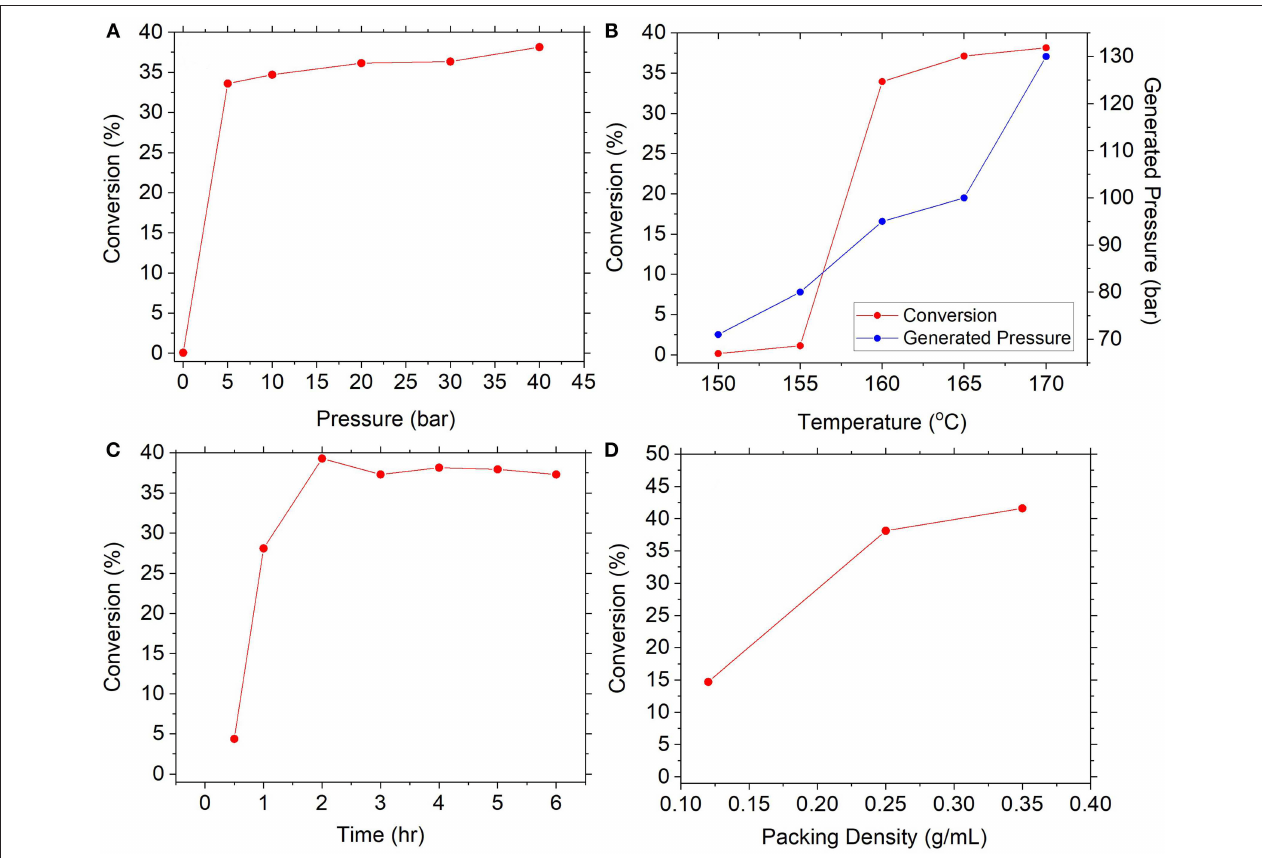
FIGURE 6 | Effect of various reaction conditions on conversion of ammonium carbamate, namely (A) pressure, (B) temperature, (C) reaction time, and (D) carbamate packing